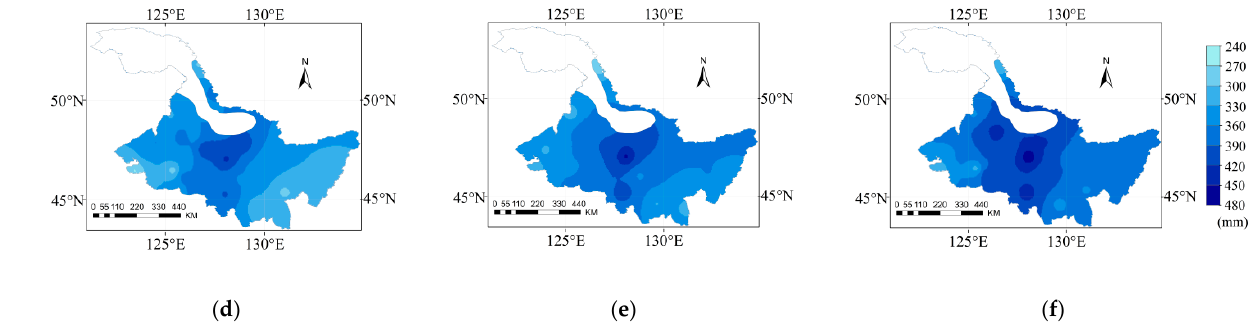
Figure 8. Spatial distribution of effective precipitation ( P e ) during the ( a ) 2030s, ( b ) 2050s, and ( c ) 2070s under RCP4.5, and during the ( d ) 2030s, ( e ) 2050s, and ( f ) 2070s under RCP8.5 during the soybean growth period.